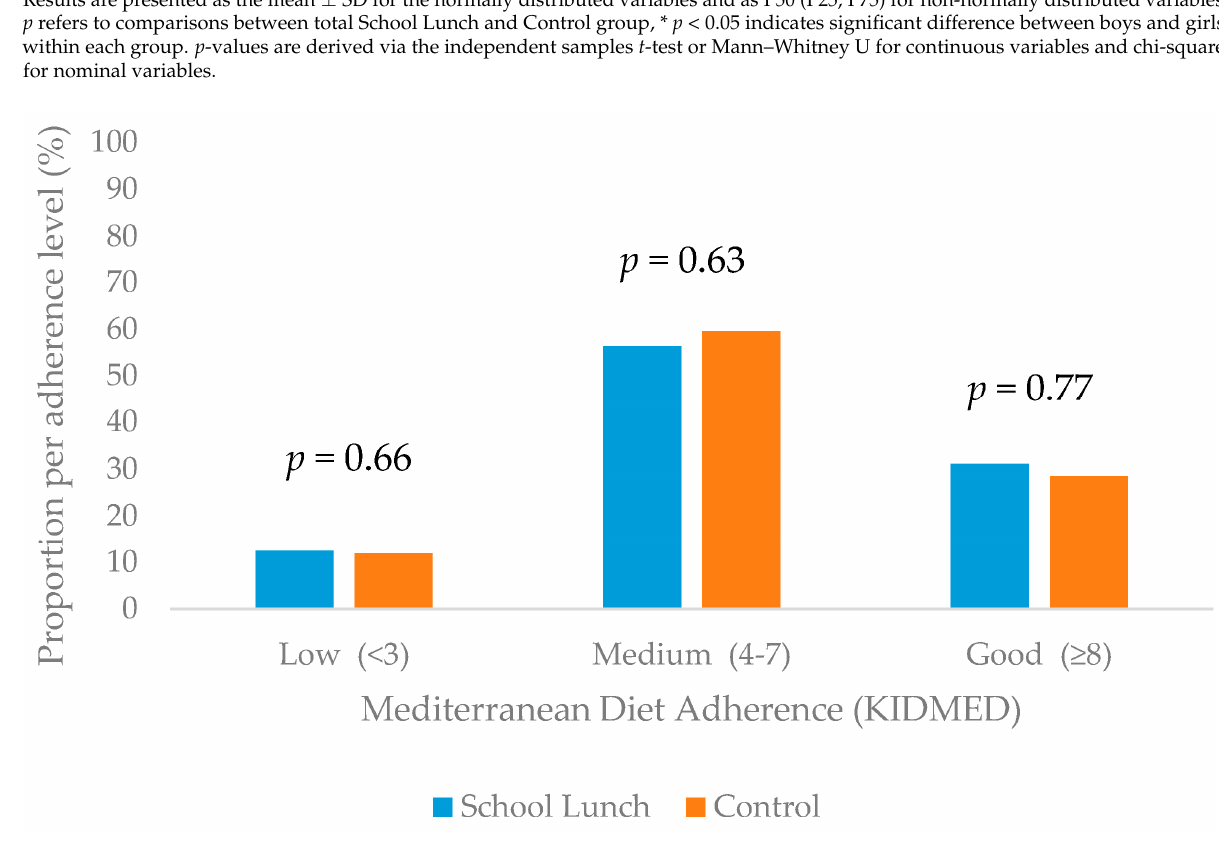
Figure 1. Adherence to Mediterranean Diet of children participants.